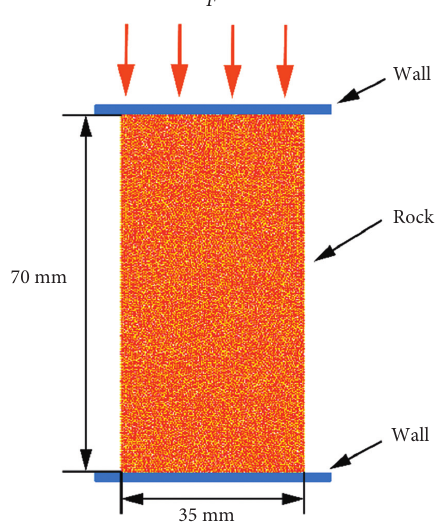
Figure 1: Rock model and boundary